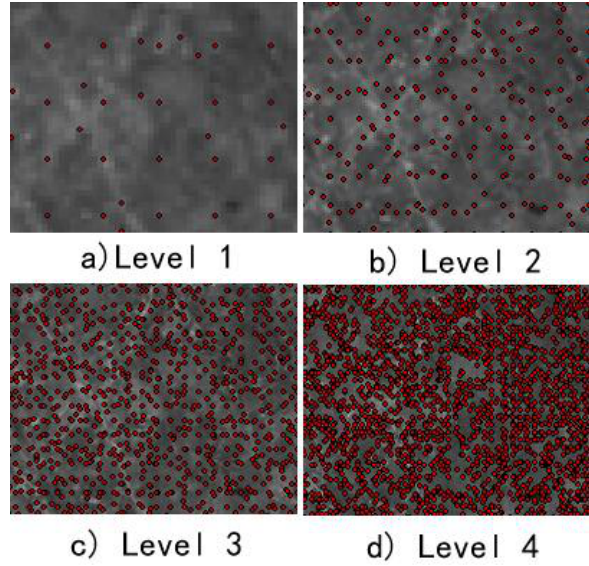
Figure 5. Matched points in hierarchical image pyramid Fig. 5 shows the matched points including feature points